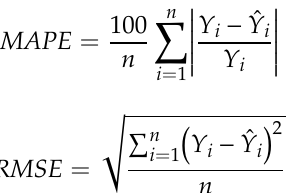
Figure 8. Examples of input sequence generation–( a ) example of case 1; ( b ) example of case